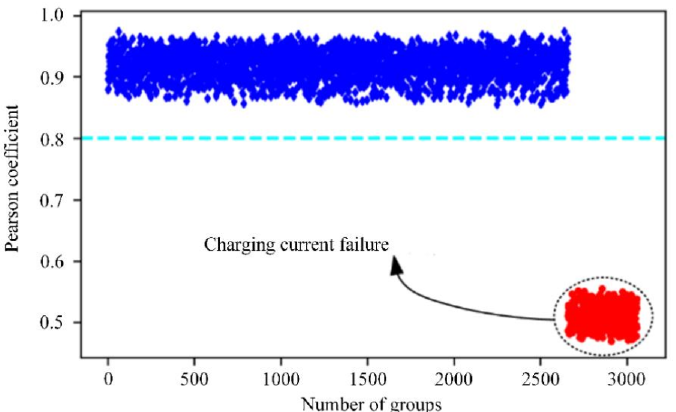
Figure 8. Change of Pearson coefficient of ADBN 2 predicted output and measured